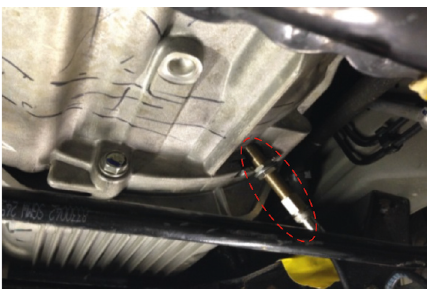
Figure 21: Flywheel torsional vibration test.